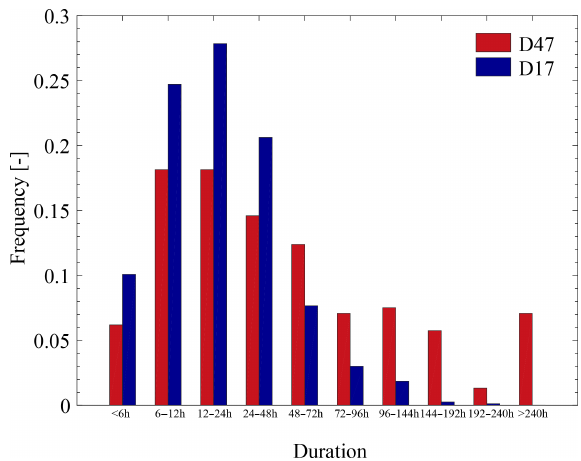
Figure 4. Distribution of durations of drifting-snow events at D47 (red) and D17 (blue). The minimum values of duration and drifting- snow mass transport for an event to be retained in the statistics are respectively set to 4h and 15kgm − 2 . Table 2. Standardized estimates of annual horizontal snow mass transport in drift